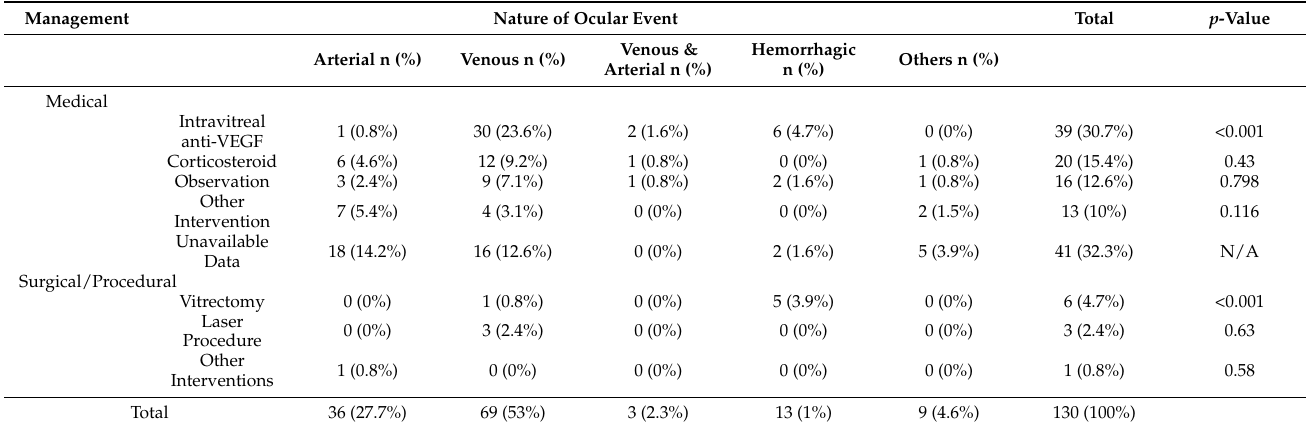
Table 4. Medical & surgical interventions for included cases.